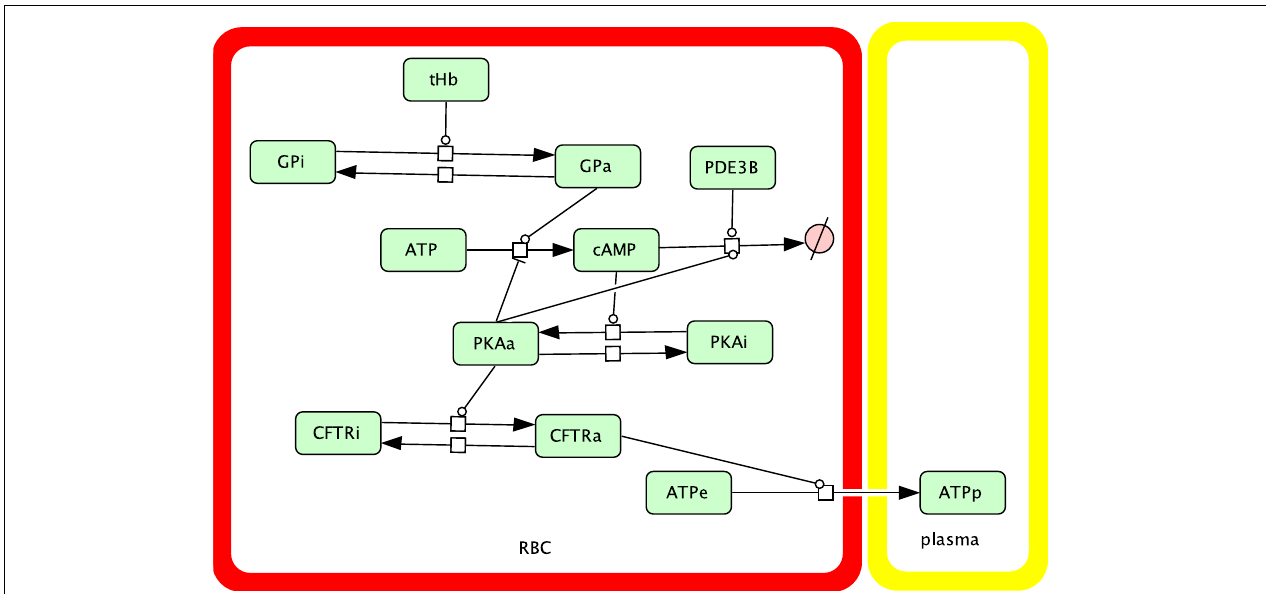
FIGURE 2 | Schematic showing the components and interactions included in our dynamic model of the oxygen-dependent erythrocyteATP release pathway.